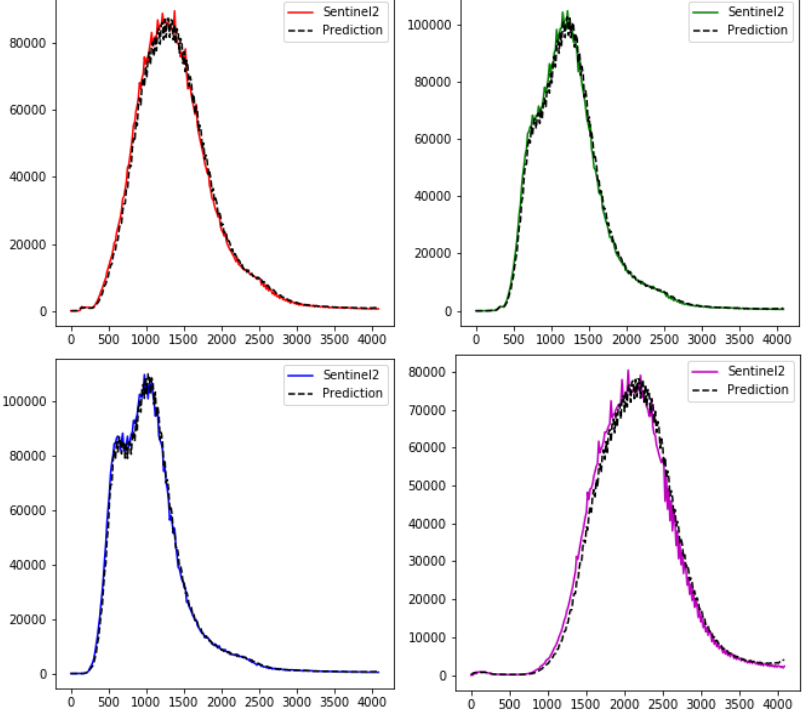
Figure 16. Comparison between input and predicted (scaled by 16) histograms with the complete S2 image associated with La Habra area (test